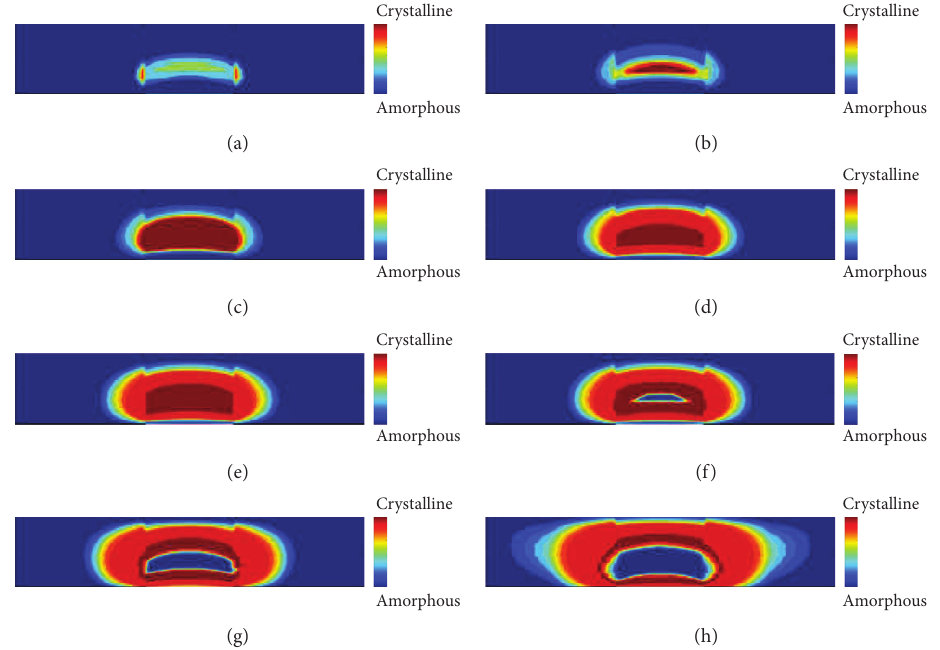
Figure 15: Phase distribution of simulation 5. (a–h) The phase distribution of GST after imposing 1, 2, 4, 7, 9, 10, 14, and 18 continuous pulses on the resistance change unit,